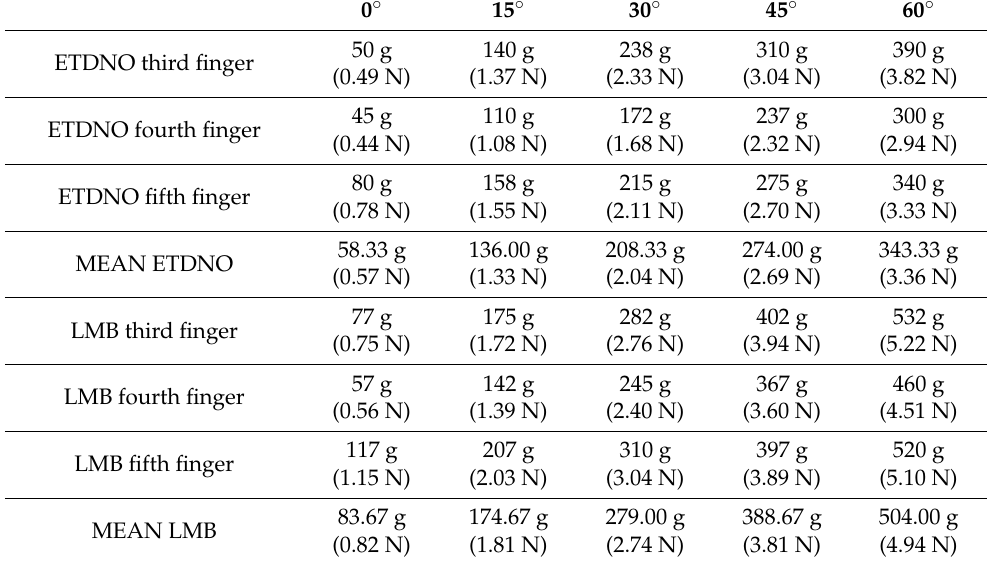
Table 1. Forces of straight tube ETDNO and LMB 501 orthosis for three different fingers and mean force of the orthosis at different positions.